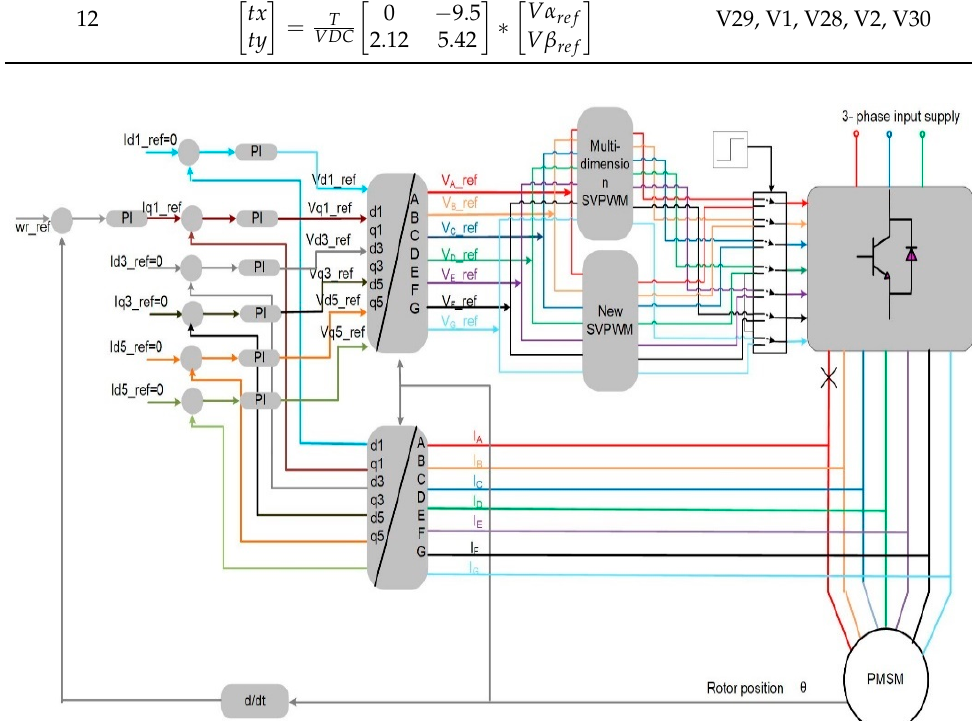
Figure 12. Seven ‐ phase drive control structure after losing phase ‘A’. Figure 12. Seven-phase drive control structure after losing phase